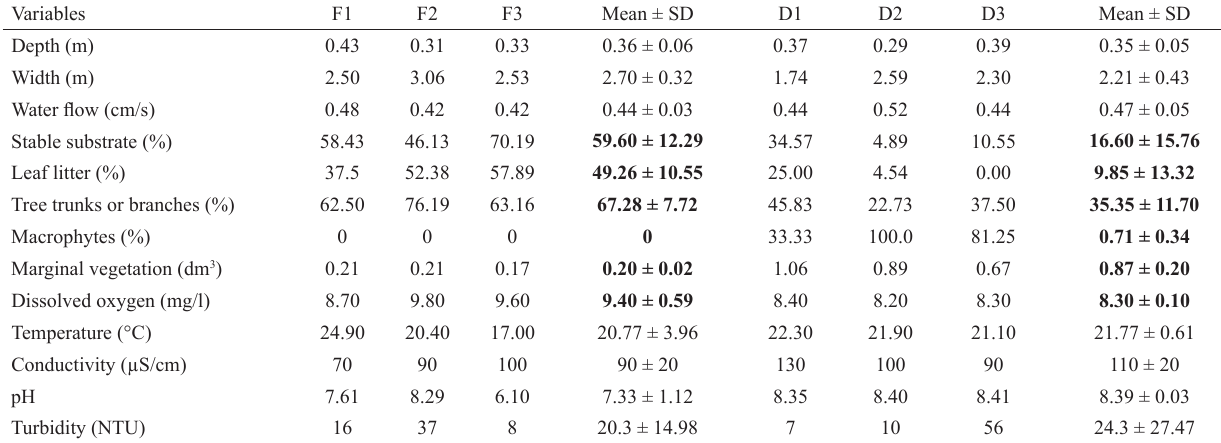
Table 1. The mean ± standard deviation (SD) of the structural and physicochemical variables of forested (F1 to F3) and deforested (D1 to D3) streams. Significant differences between the groups of streams are in bold (t-test, P < 0.05). Variables